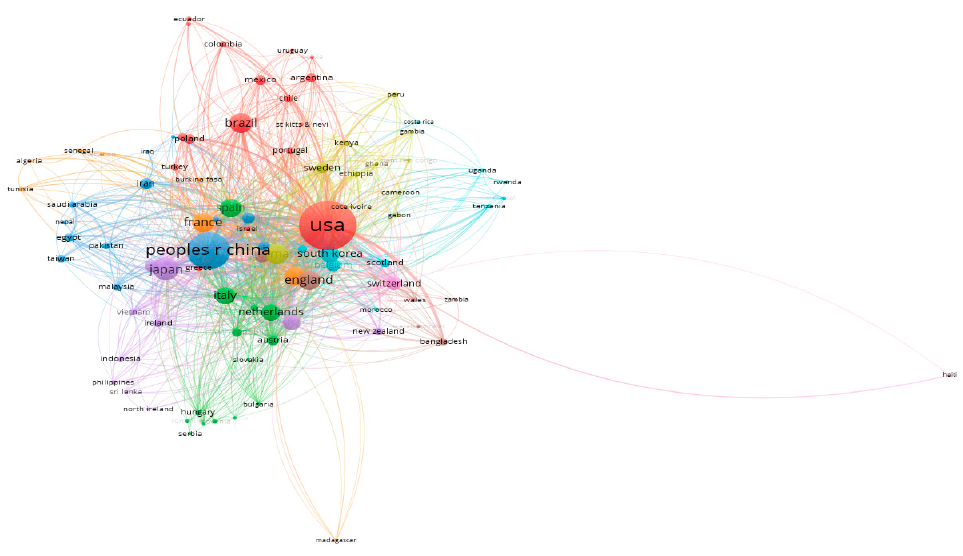
Figure 12. Co-authorship map of countries collaborating in resource recovery from human and animal waste.